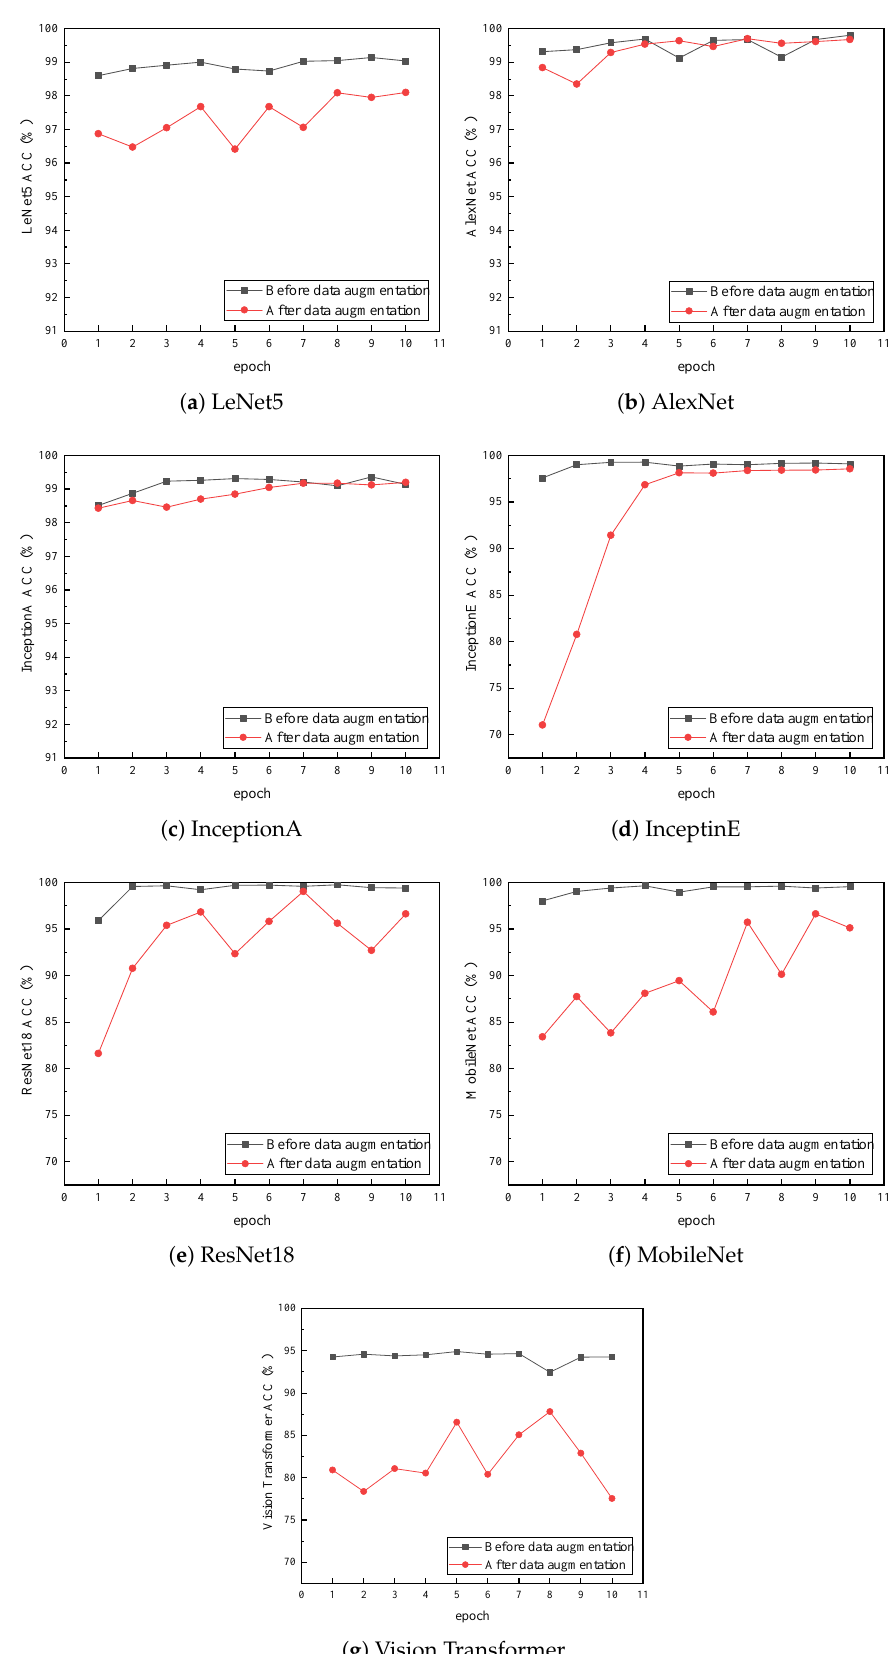
Figure 11. Comparison of the accuracy of each model before and after data